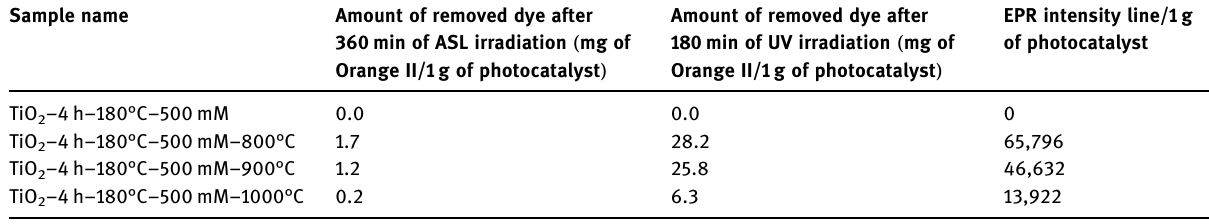
Table 4: Summary of photoactivity for Orange II decomposition under UV and ASL radiations and the intensity of the EPR signal line per gram of calcined APTES/TiO 2 photocatalysts